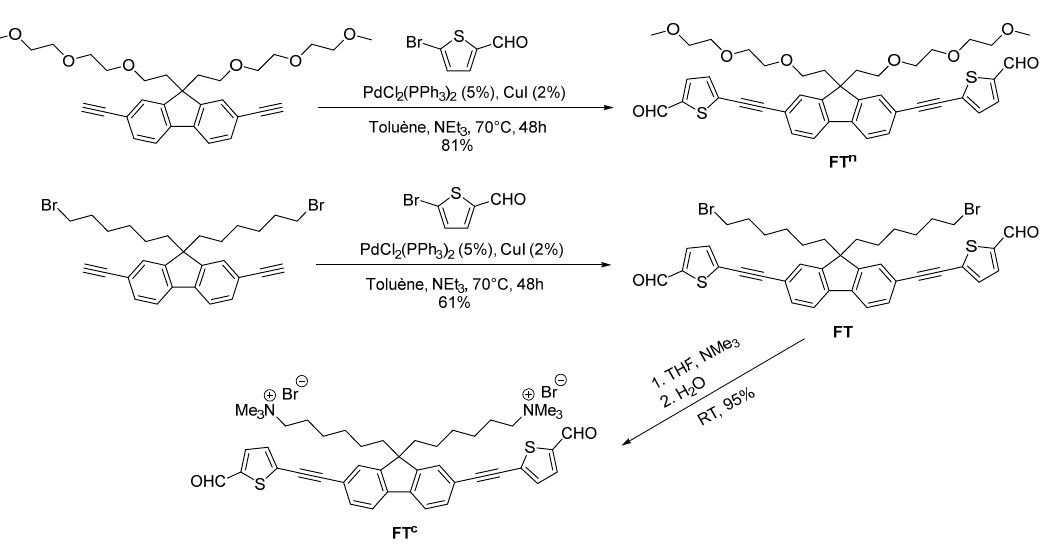
are fluorescent π -conjugated units (F, in red) and cationic arginine units (+, in